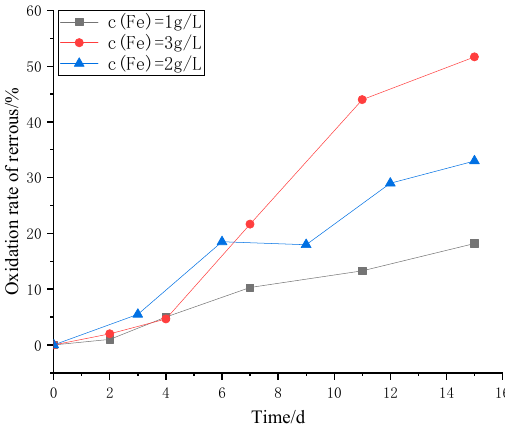
Figure 6. Oxidation rate of Fe(II) under different oxygen pressures (c(Fe(II)) is 2 g/L).